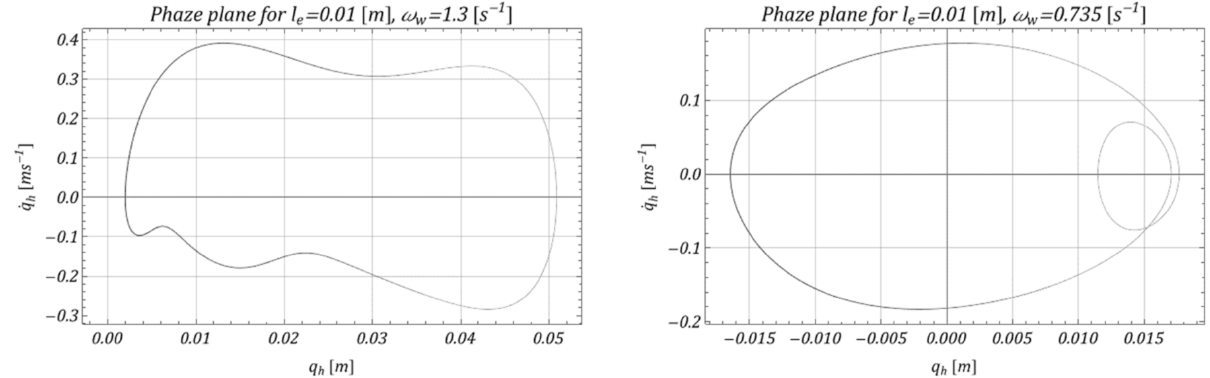
Figure 11. Phase diagrams related to selected solutions—periodic solutions for l e = 0.01